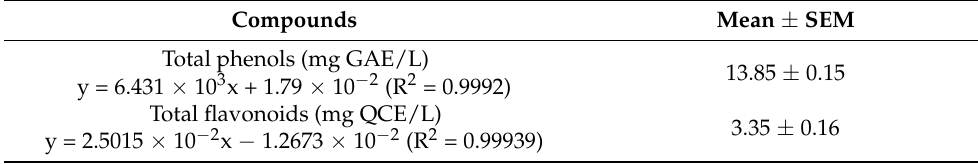
Table 5. Total phenol and flavonoid content mean values of ginger extract (n =